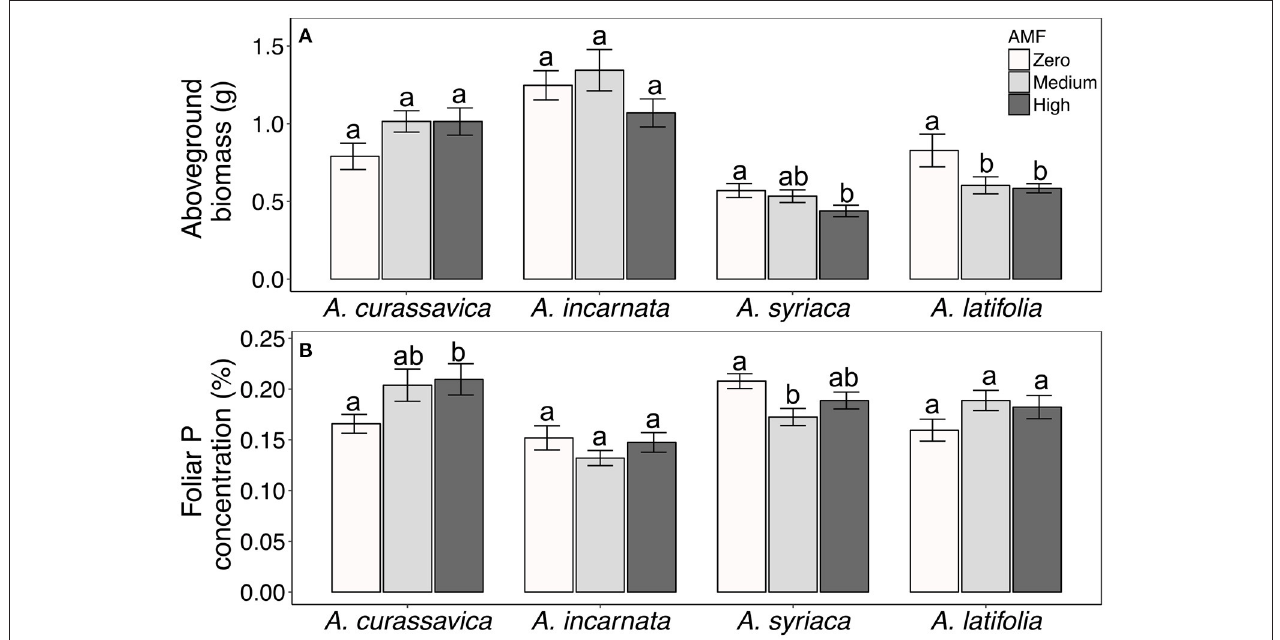
FIGURE 5 | (A) Aboveground biomass and (B) foliar phosphorus (P) concentrations of four milkweed species. Sample sizes range from 17 to 20 plants per treatment for aboveground biomass and 9–10 plants per treatment for P concentrations. Bars display the mean ± 1SE. Different letters indicate significantly ( P < 0.1) different AMF treatment means within each plant species (Tukey post-hoc test of the ANOVA within plant species).